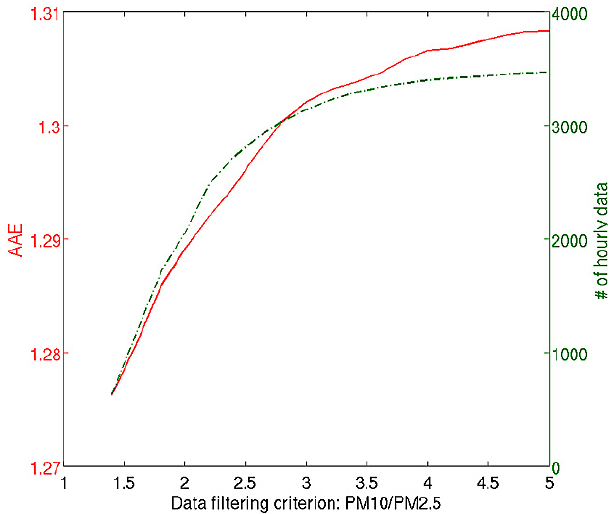
Fig. 5. AAE (Absorption ˚Angstr¨om Exponent), as obtained from averaged aethalometerabsorption coefficients at 370, 470, 520, 590, 660, 880 and 950nm. Absorption data are averaged after remov- ing the values corresponding to PM 10 /PM 2 . 5 being greater than a threshold (i.e. data filtering criterion). PM 10 /PM 2 . 5 refers to the mass density ratio of PM 10 to PM 2 . 5 , and is used as an indicator of dust influence.